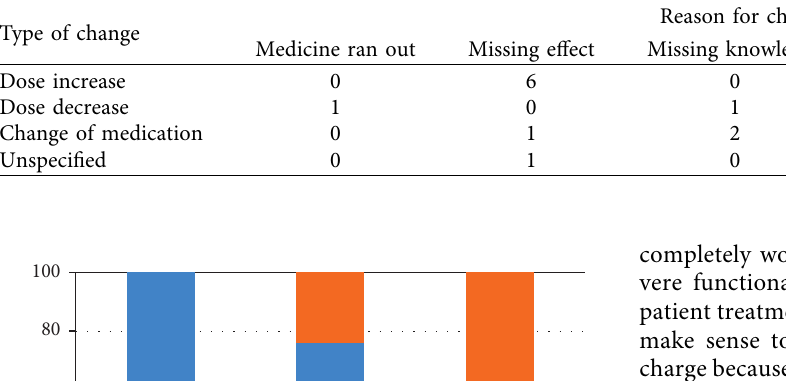
Table 3: Type of medication change and the reason for change (the number of patients).